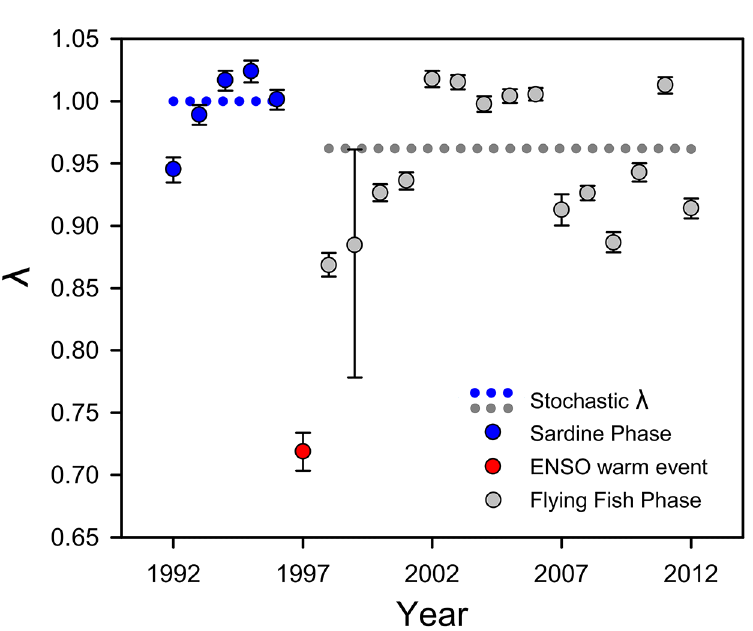
Fig 6. Deterministic annual λ (population growth rate) values from age-classified, single-sex (female) population projection models for Nazca boobies. λ > 1 signifiesa growingpopulation.Brackets show 95% CIs. Interval is particularly large for 1999becauseof almost completebreedingfailure and nearly complete survival for most age classes, so that the rate of populationshrinkagedependsdisproportionatelyon survival in the final age class (age 22+), a value predictedwith low precisionbecausesample size declineswith age. Stochastic λ values specific to each fish phase shown with dotted lines.